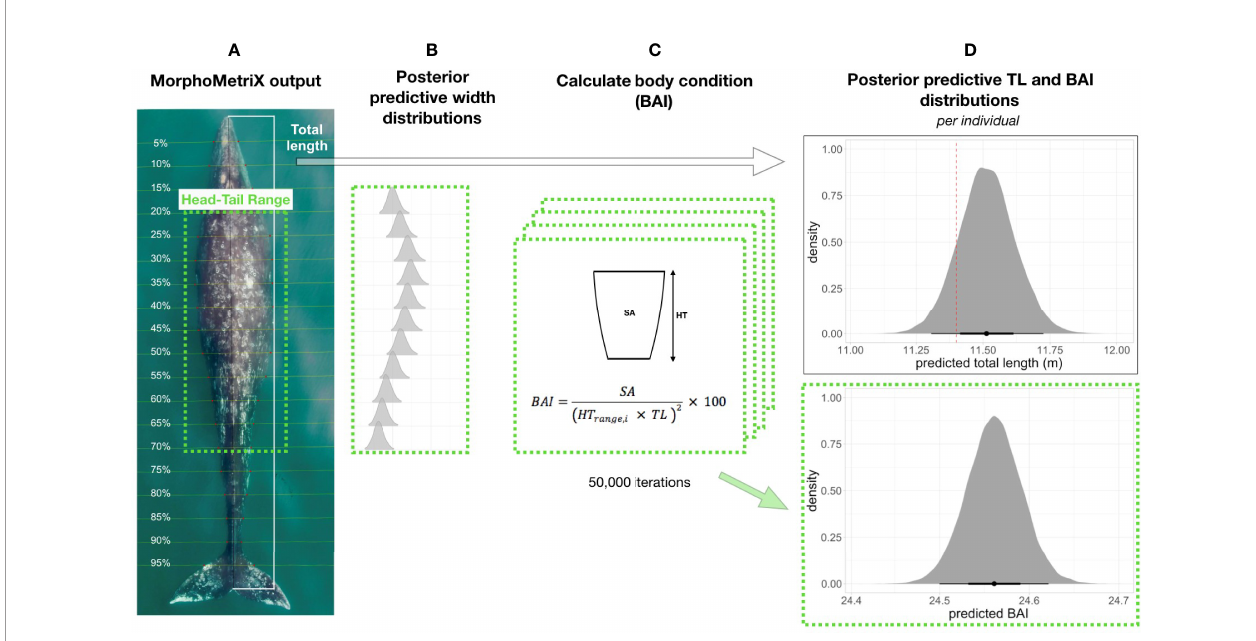
FIGURE 2 | Overview of Bayesian framework for calculating the body condition of gray whales. (A) An example of a MorphoMetriX output (Torres and Bierlich, 2020) from a UAS image of a gray whale. Total length (TL) measured from rostrum to fl uke notch with perpendicular widths segmented in 5% increments of TL. Head-Tail Range (20 – 70%) represents the region of the body used to calculate body condition, which excludes the fi ns, head, and tail. (B) Posterior predictive distributions for each 5% width included in the Head-Tail Range that is used to calculate body condition. (C) Body condition is calculated as Body Area Index (BAI) for each iteration in the Markov Chain Monte Carlo output of each posterior predictive width distribution using CollatriX (Bird and Bierlich, 2020). (D) Posterior predictive distributions for TL and BAI for a single individual. On the x-axis, the longer thin black bars represent the 95% highest posterior density (HPD) interval, the thicker shorter black bars represent the 65% HPD interval, and the black dot represents the mean value. The red dashed line represents the maturity cutoff length (11.4 m).